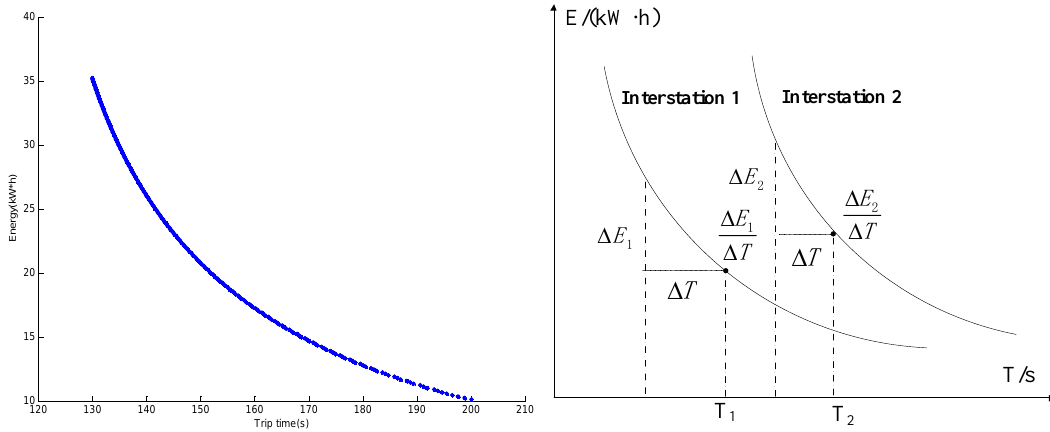
Figure 5. Influences of the trip time on the traction energy consumption.